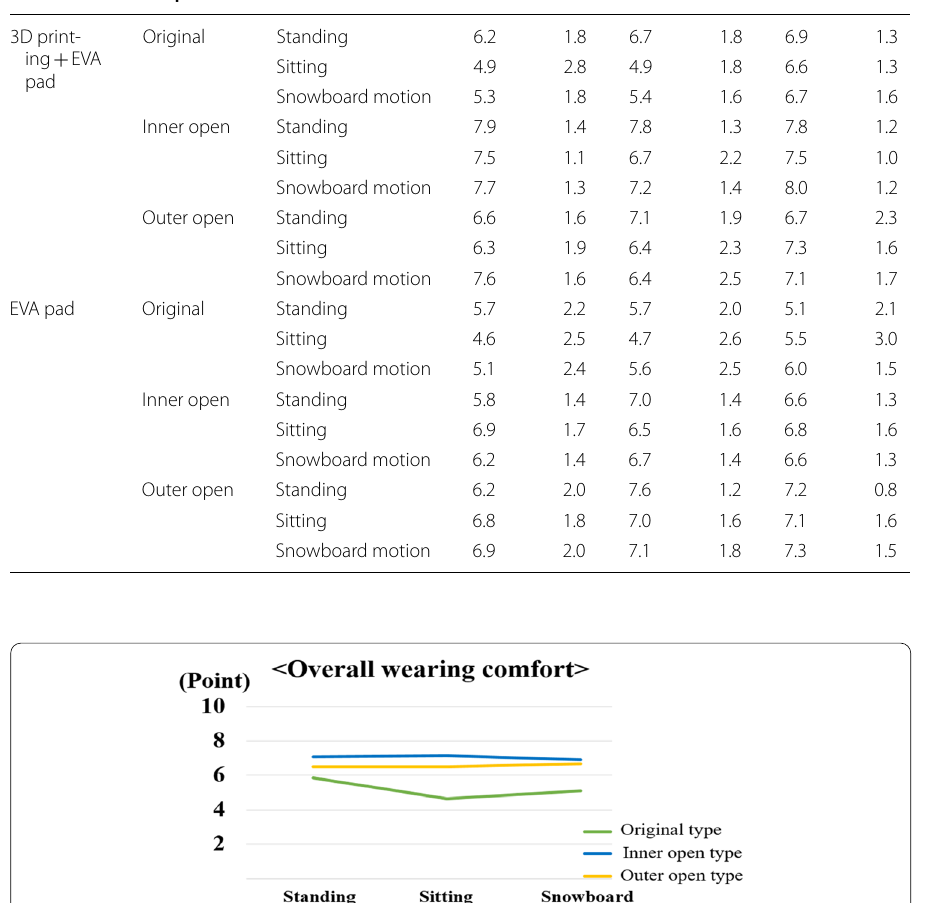
age 7.0 points) was observed when wearing the inner open-type pad ( p < .01). Further- more, wearing the outer open-type pad also resulted in better wearing comfort than the